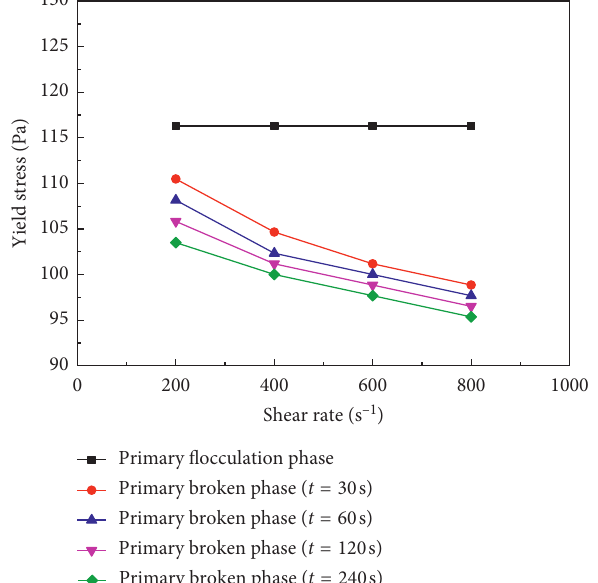
Figure 3: The variation of yield stress with shear rate during different shear times in the primary flocculation and primary broken